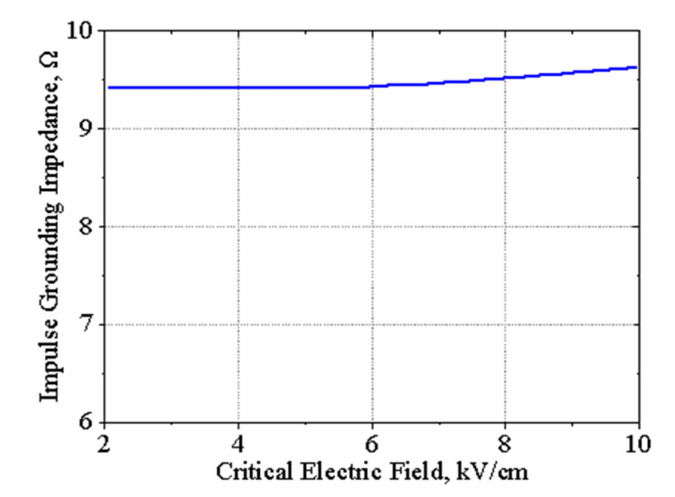
Figure 13. Influence of the critical electric field on the impulse grounding impedance of a 1 × 1 mesh of 10 m, soil resistivity of 500 Ω m, current peak of 100 kA and 1/200 µ s waveform.